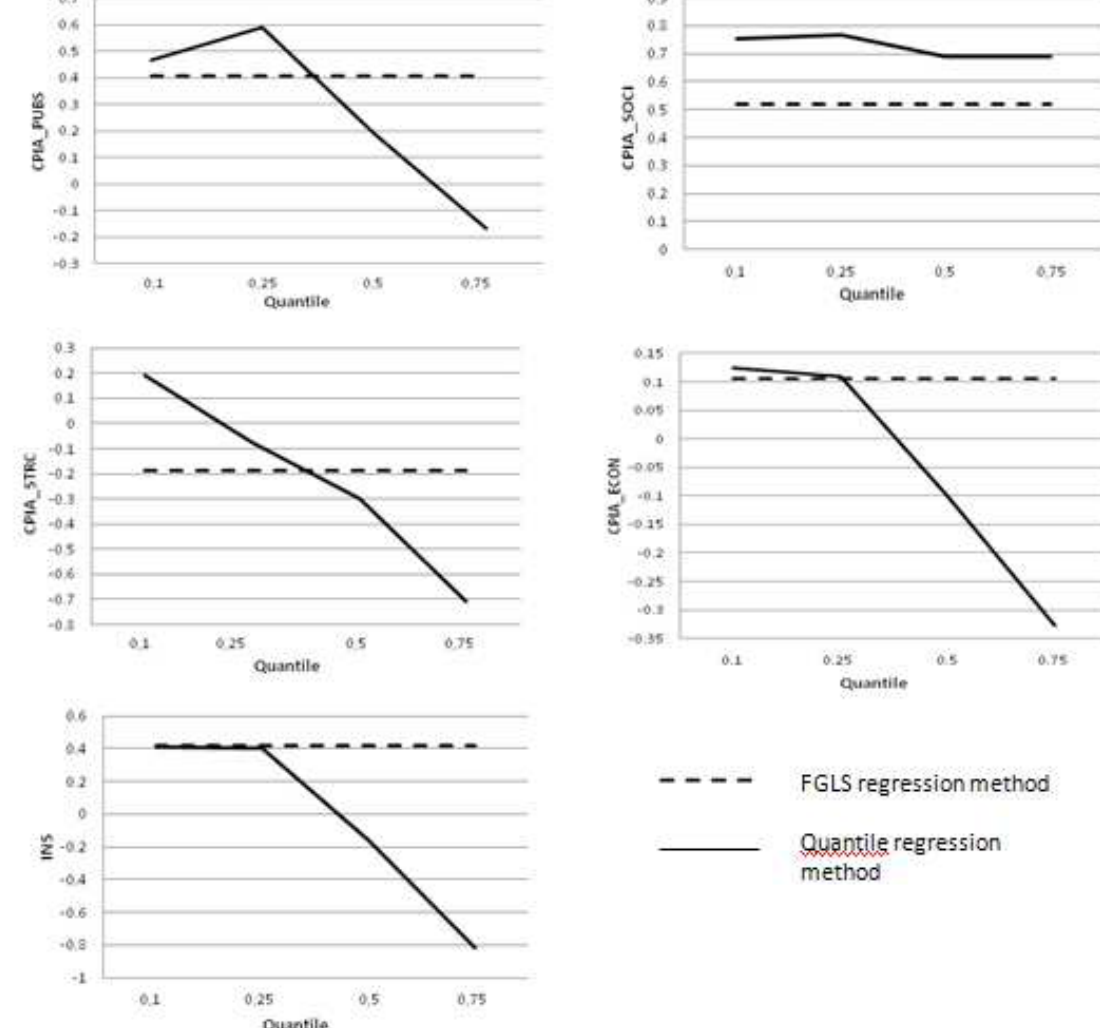
Figure 1. Regression coefficients of the institutional variables based on the FGLS regression and quantile regression